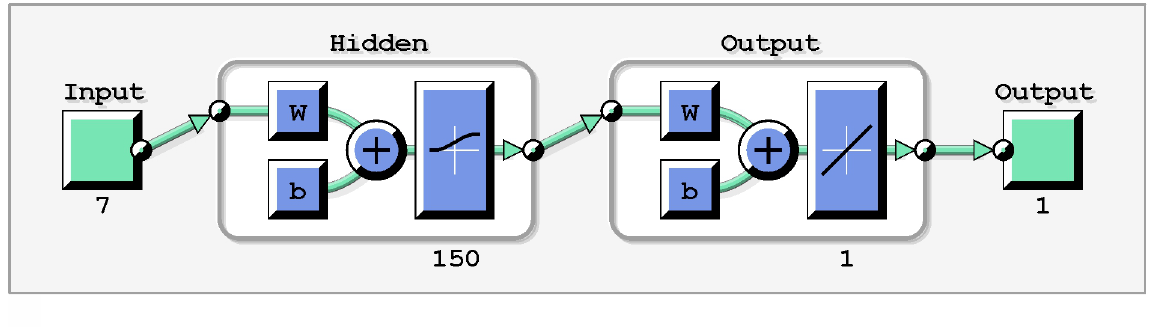
Figure 2. The architecture of the ANN model that was used to derive the radial solar wind